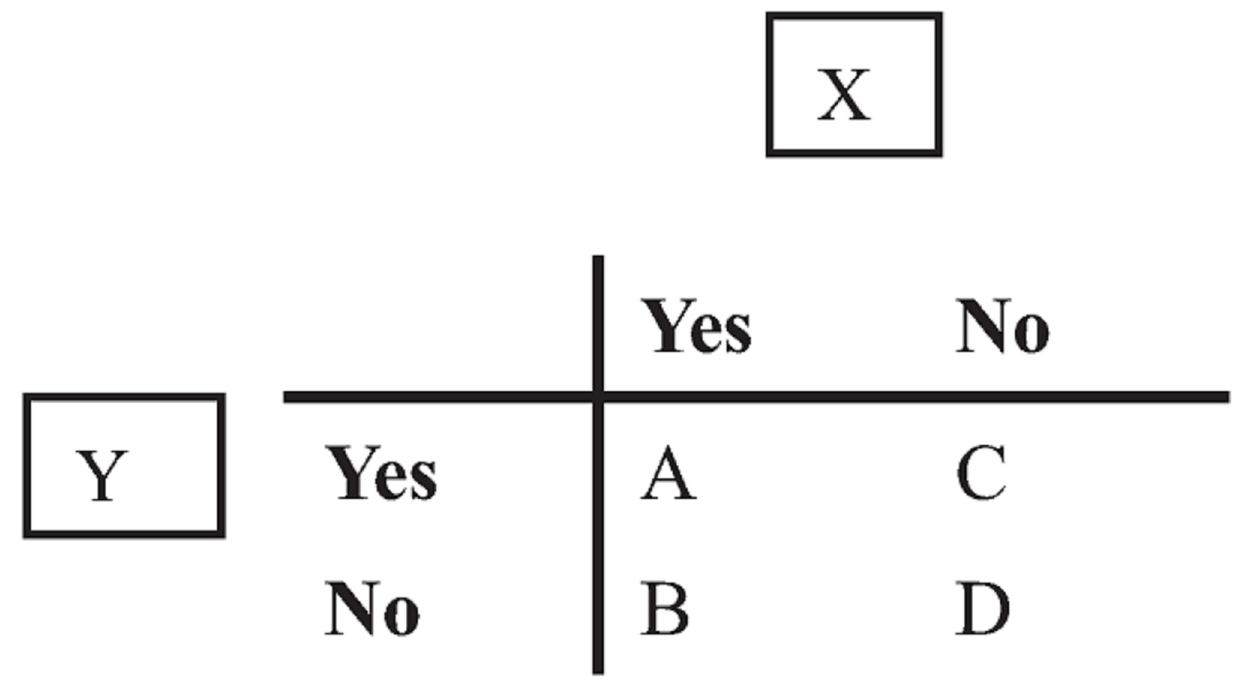
Fig 1. Contingency